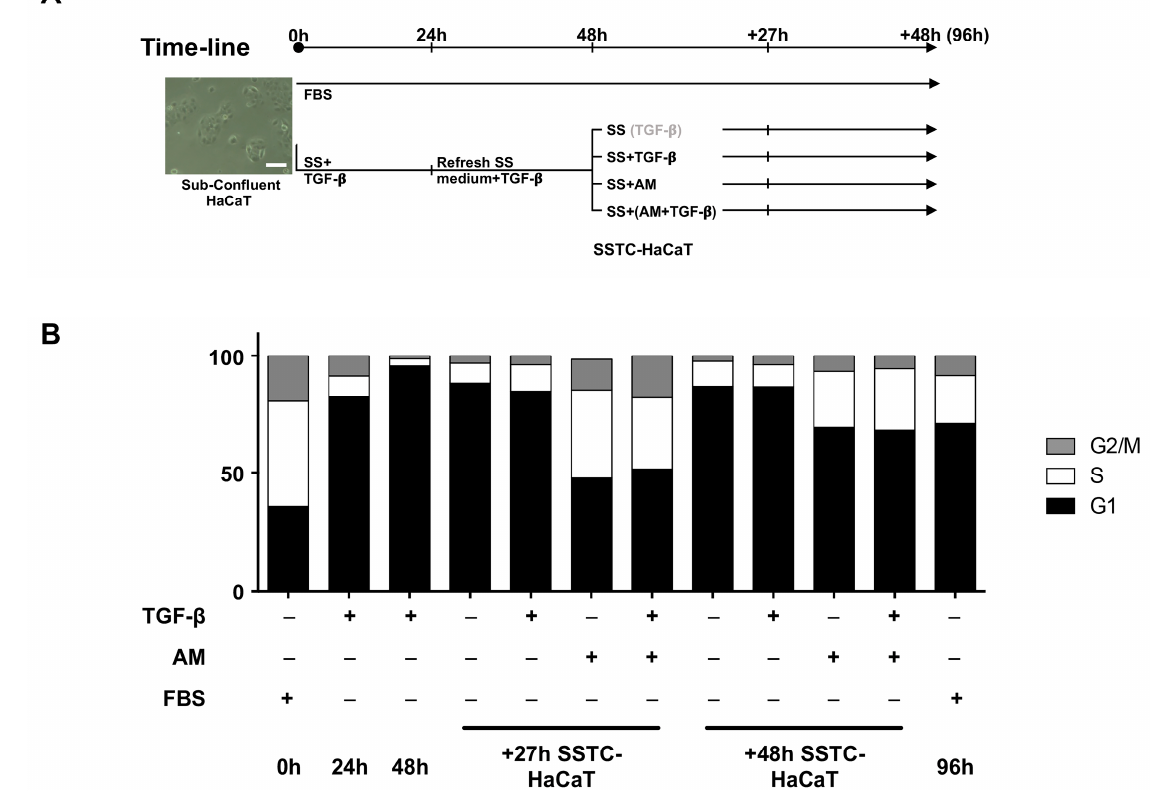
Figure 6. Amniotic membrane treatment reignites the proliferation of keratinocytes despite strong cell-cycle arrest status. ( A ) Illustrative scheme of the subconfluent HaCaT cells culture setup used. ( B ) Cell cycle progression was assessed through flow cytometry. Cells were analyzed at the indicated times for each condition and treatment. Replicates from three independent experiments were analyzed and represented. The scale bar equals 100 µm.